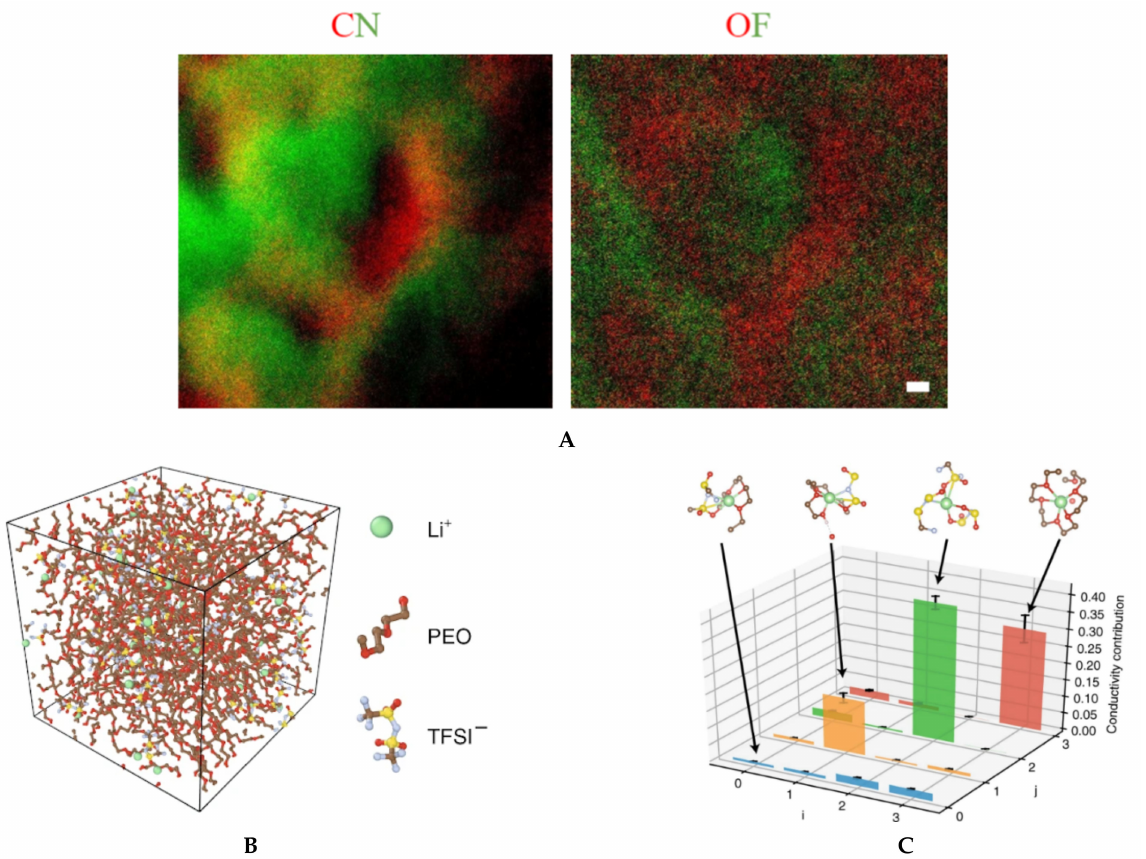
Figure 7. ( A ) Elemental mapping of fullerene-modified PEO/LiTFSI (10/1 by weight) solid electrolytes by low-dose EFTEM. The two colored images are: carbon map in red with nitrogen in green (left), and oxygen map in red with fluorine in green (right). The two images were taken from the same region and share the same scale bar of 20 nm. These are unpublished images related to the work published in reference [79]. ( B ) and ( C ) A four-state dynamical model learned for lithium ion in a PEO/LiTFSI polymer electrolyte. ( B ) Structure of the PEO/LiTFSI polymer electrolyte. ( C ) Contribution from each transition to lithium ion conduction. Each bar denotes the percentage that the transition from state i to state j contributes to the overall lithium ion conduction. The error bars report the 95% confidence interval from four independent trajectories in the test data. Figure 7B,C reproduced from [80], under the terms of the Creative Commons CC BY license [18]. No changes have been